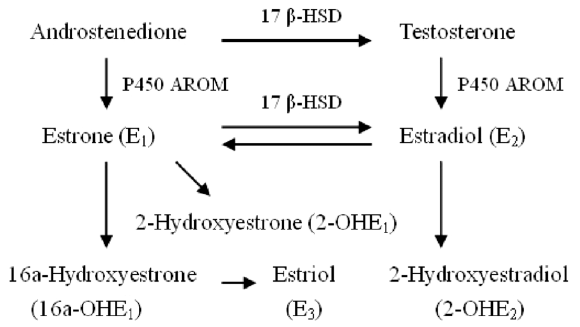
Figure 1. Estrogen metabolism pathways, including estrone, estradiol, and estrogen metabolites. 17 b -HSD: 17beta-hydroxy- steroid dehydrogenase; P450 AROM: cytochrome P450 aromatase.